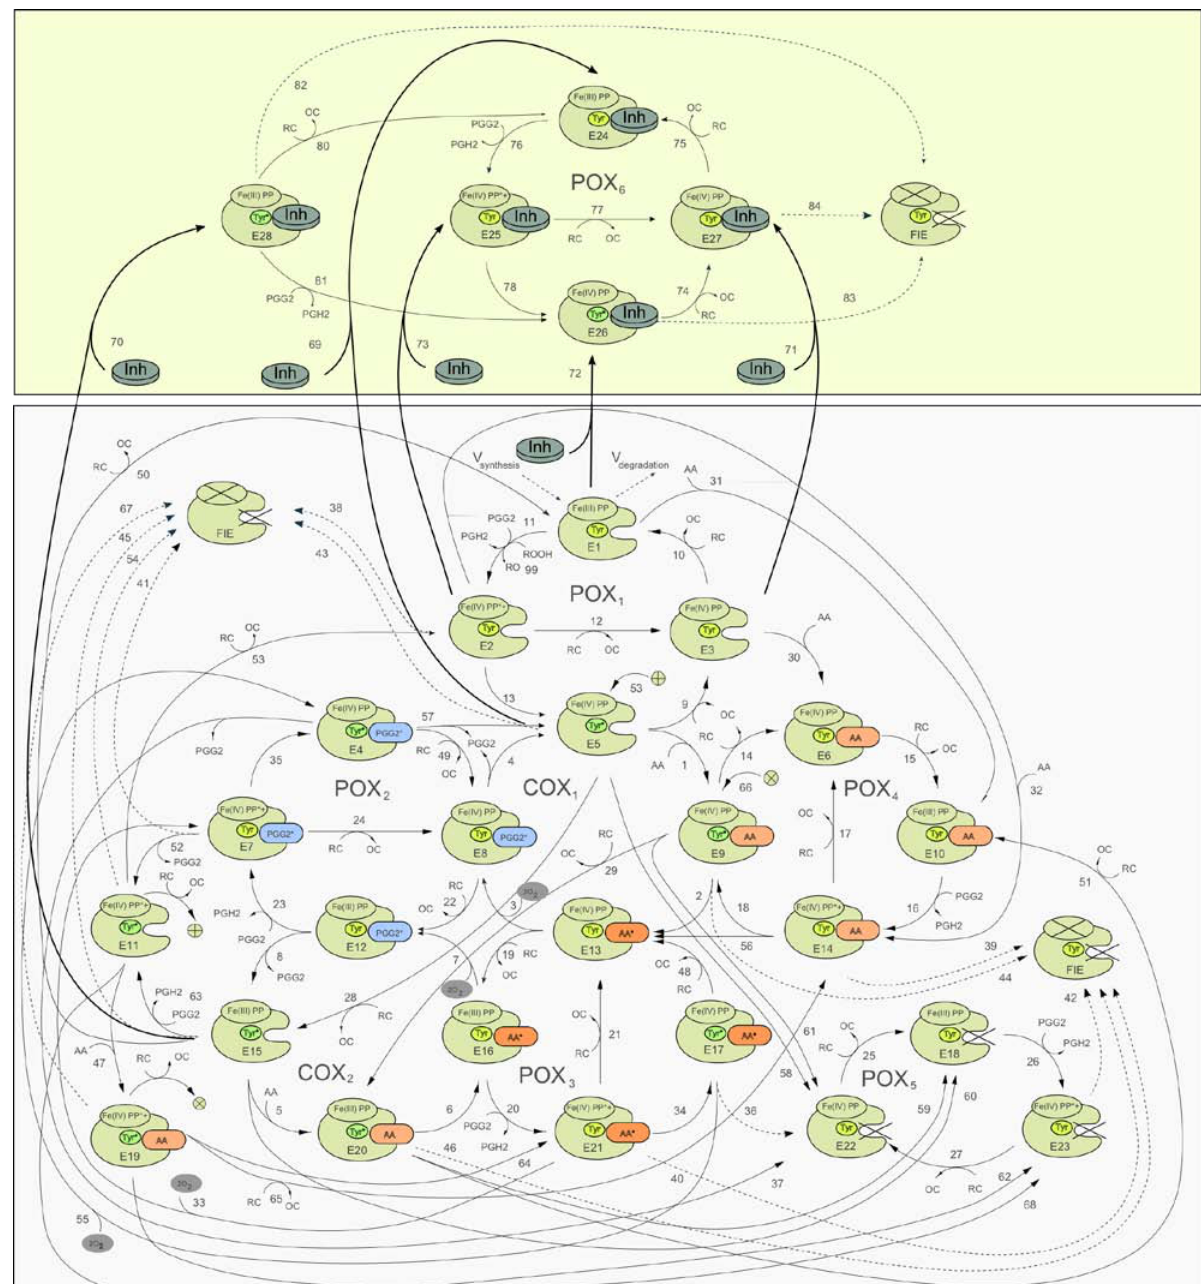
Figure 1. Scheme of catalytic cycle of PGHS with consideration of the enzyme inhibition by NSAID. Bottom panel—catalytic cycle of PGHS; top panel—scheme of NSAID (Inh) binding with the enzyme (thick lines); AA—arachidonic acid; RC—reducing cosubstrate; OC—oxidized RC; O —oxygen; PGG , PGH —prostaglandin G and H , respectively; 2 2 2 2 2 E —enzyme states; Fe(III) and F(IV)—ferric and oxiferryl states of heme iron; PP and i PP*+—protoporphyrin group in ground and radical cation states; Tyr, Tyr*—Tyrosine 385 in ground and radical states; FIE—full inactivated enzyme state; cross—enzyme inactivated sites; dashed lines—reactions of self-inactivation of